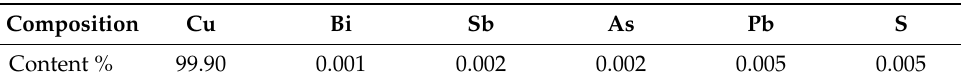
Table 2. The composition of the copper.